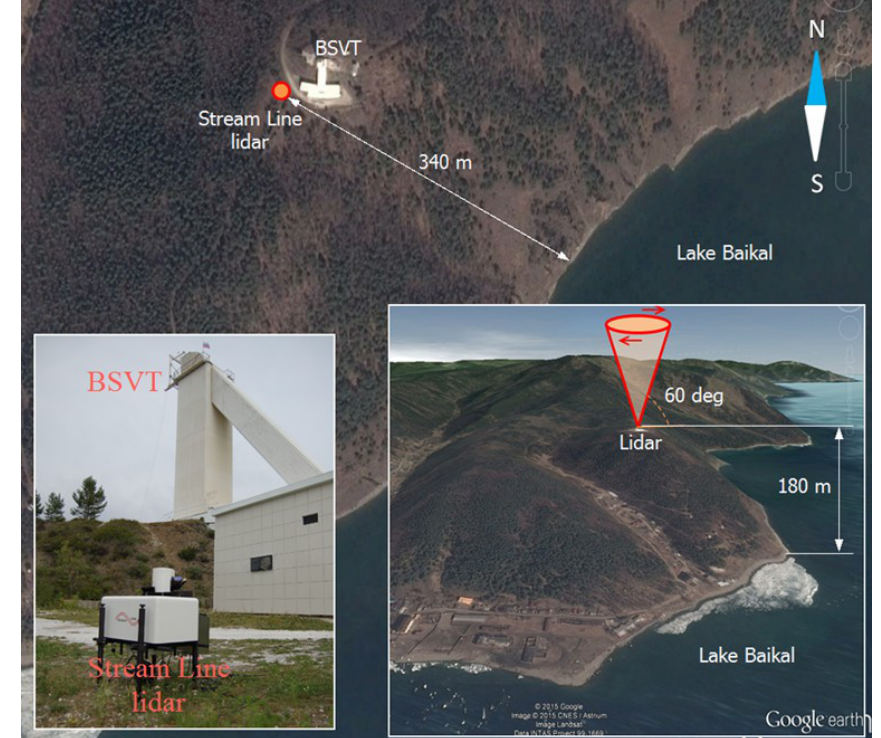
Figure 4. Map of lidar wind measurements over 14–28 August 2015.